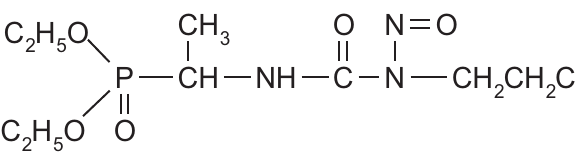
Figure 1. Structural formula of